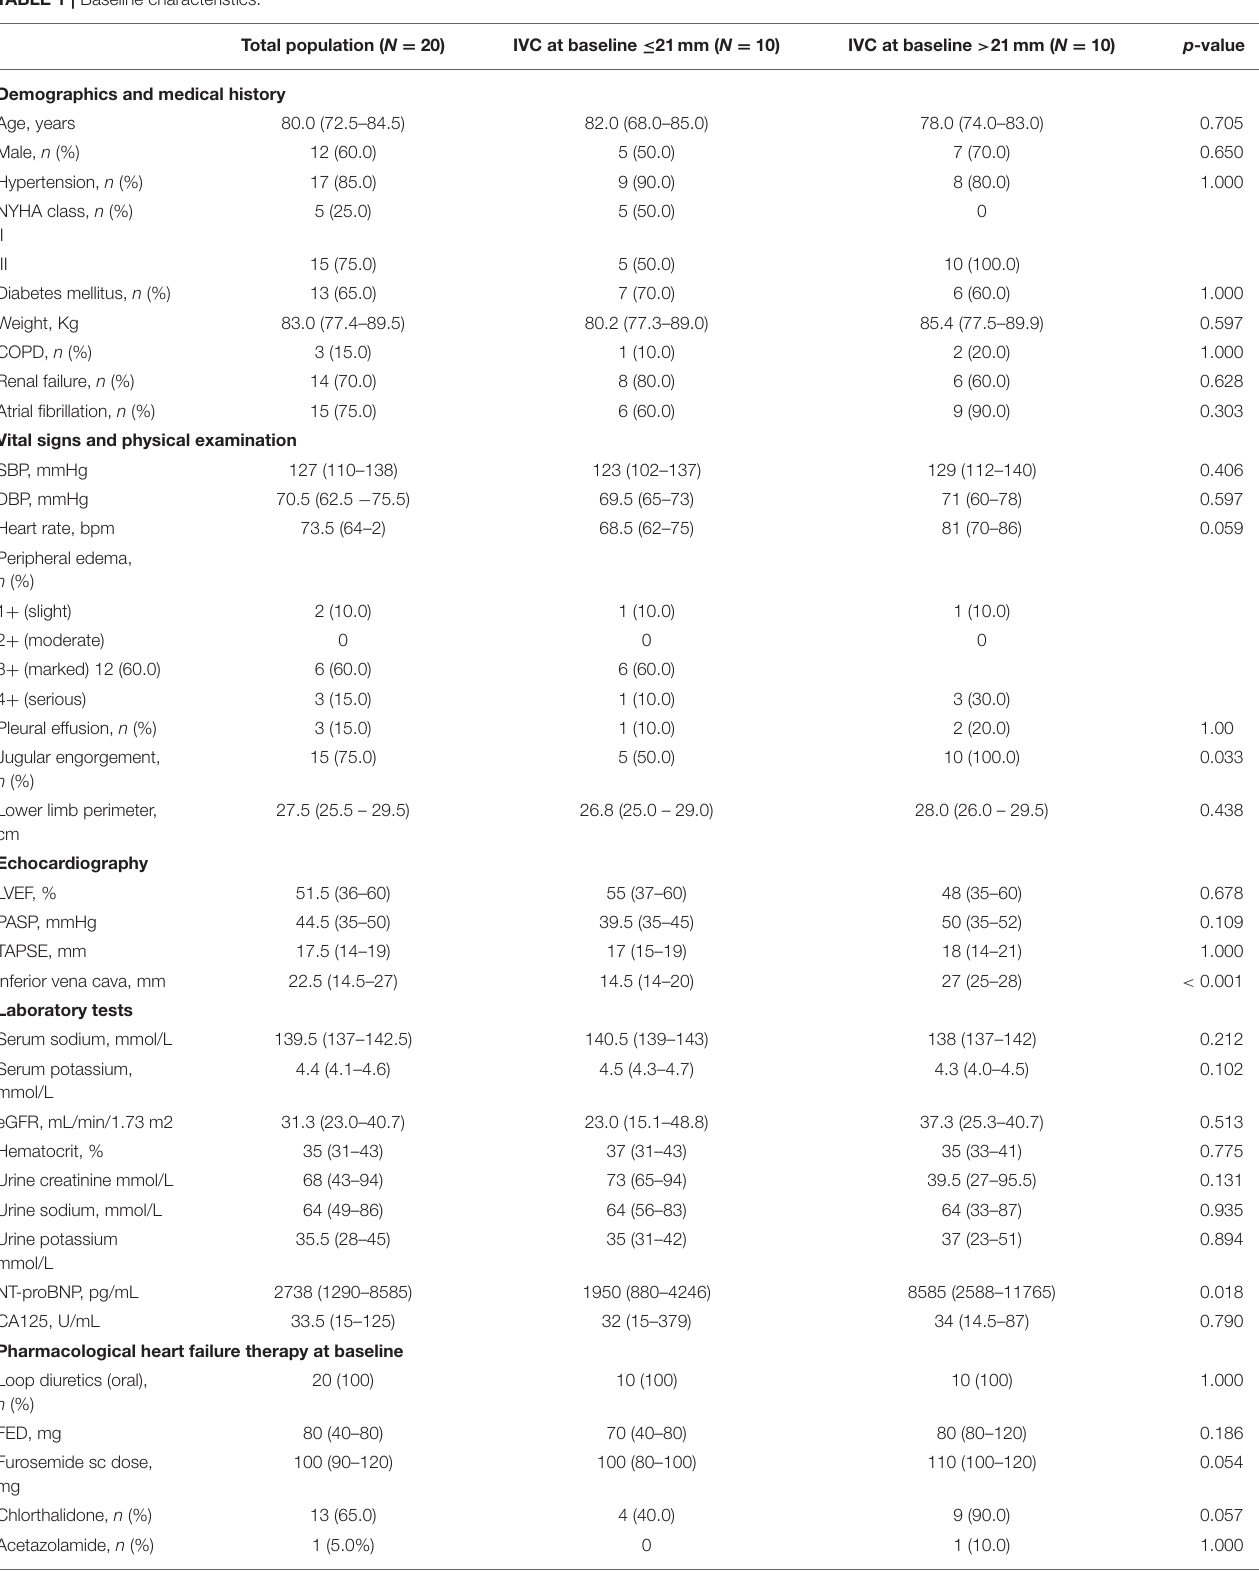
TABLE 1 | Baseline